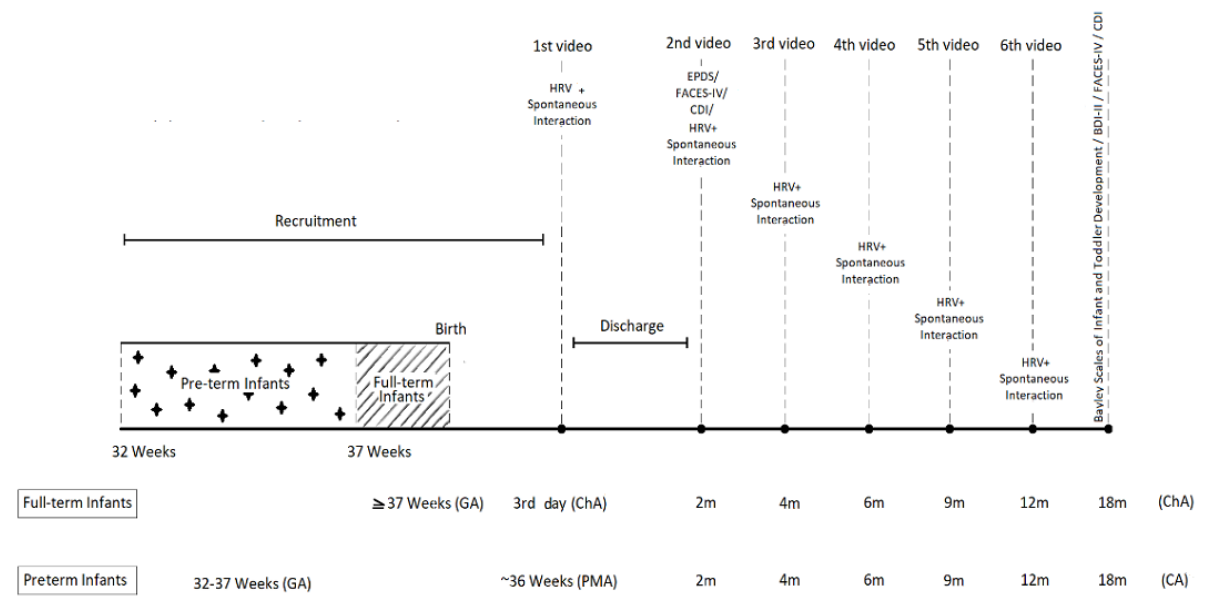
Figure 1. Timeline of the study procedure. BDI: Beck Depression Inventory; CA: Corrected Age; DCI: Dyadic Coping Inventory; ChA: Chronological Age; EPDS: Edinburgh Postnatal Depression Scale; FACES: Family Adaptability and Cohesion Evaluation Scale; GA: Gestational Age; HRV: Heart Rate Variability; PMA: Postmenstrual